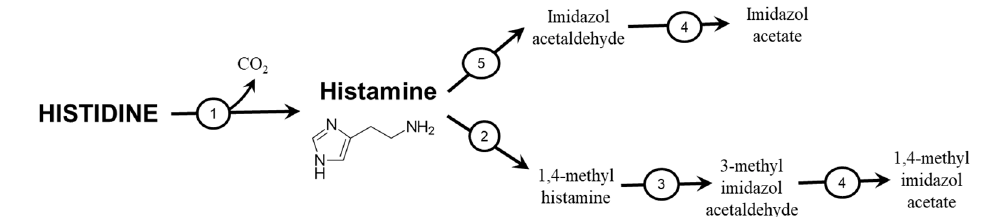
Figure 4. Synthesis and degradation of histamine: Histamine is formed by the decarboxylation of HIS by L-histidine decarboxylase (EC 4.1.1.22) found in many tissues. Released histamine is degraded to 1,4-methyl imidazoleacetic acid; the second pathway of histamine degradation is oxidation to imidazoleacetic acid. The metabolites are released in the urine or processed to other metabolites. 1, histidine decarboxylase; 2, histamine-N-methyltransferase; 3, monoamino oxidase; 4, aldehyde dehydrogenase; 5, diamino oxidase.